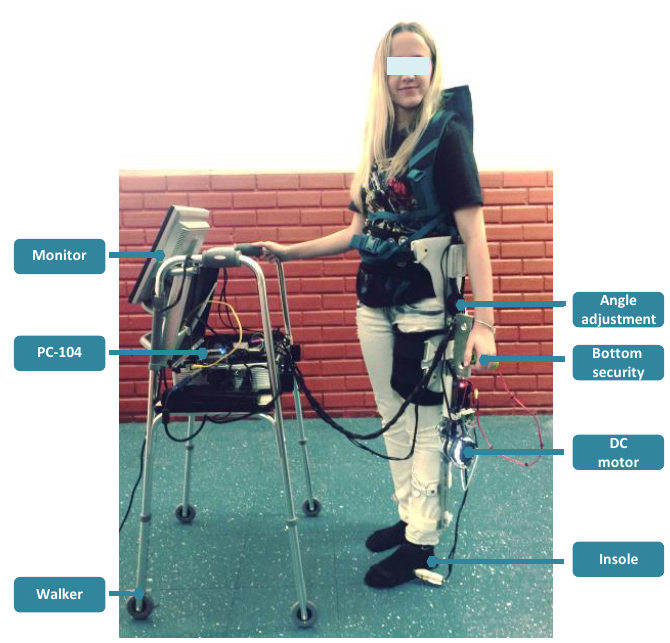
Figure 6. Advance Lower Limb Orthosis for Rehabilitation (ALLOR) built for this